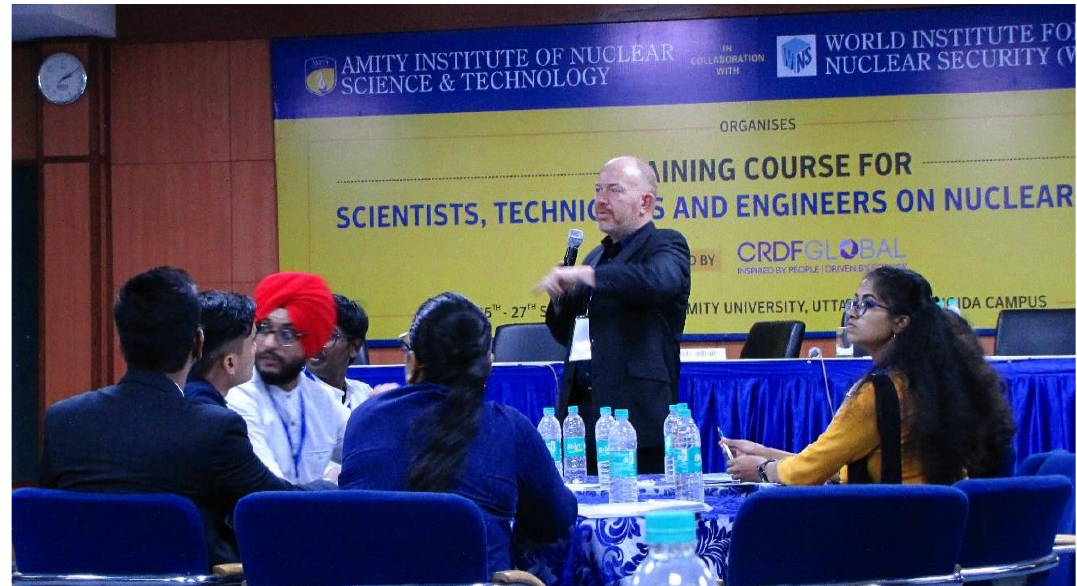
Picture 6. Mr. Carl Reynolds with the participants discussing the objectives of the training program during